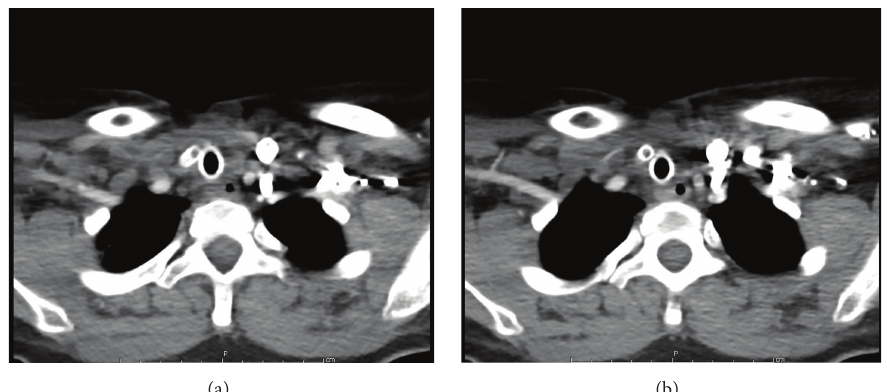
Figure 1: (a, b) Tracheocarotid fistula with carotid stent in place.